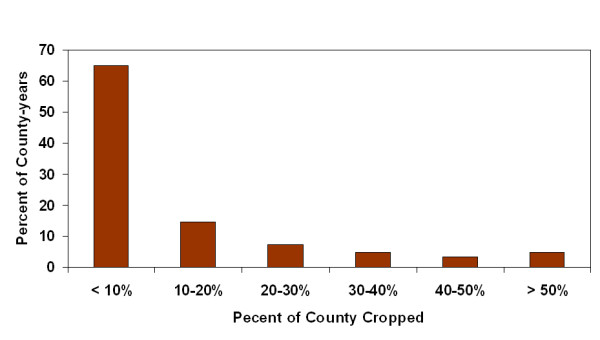
Frequency distribution of county-year cropping intensity for total corn, sorghum, wheat and cotton.